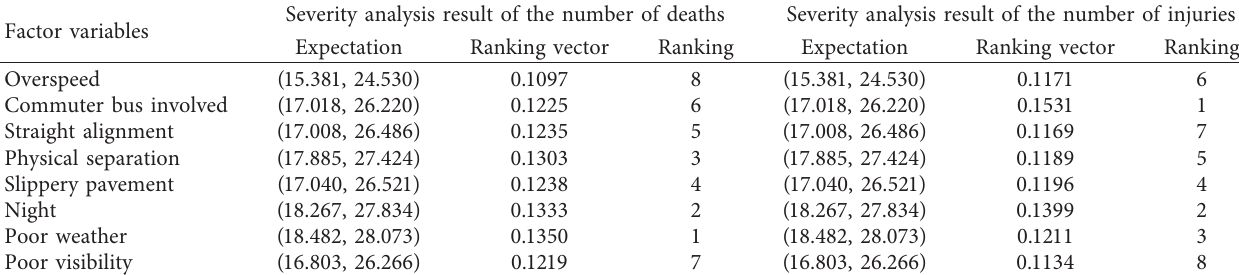
Table 8: Risk degree raking of single-vehicle traffic accidents.